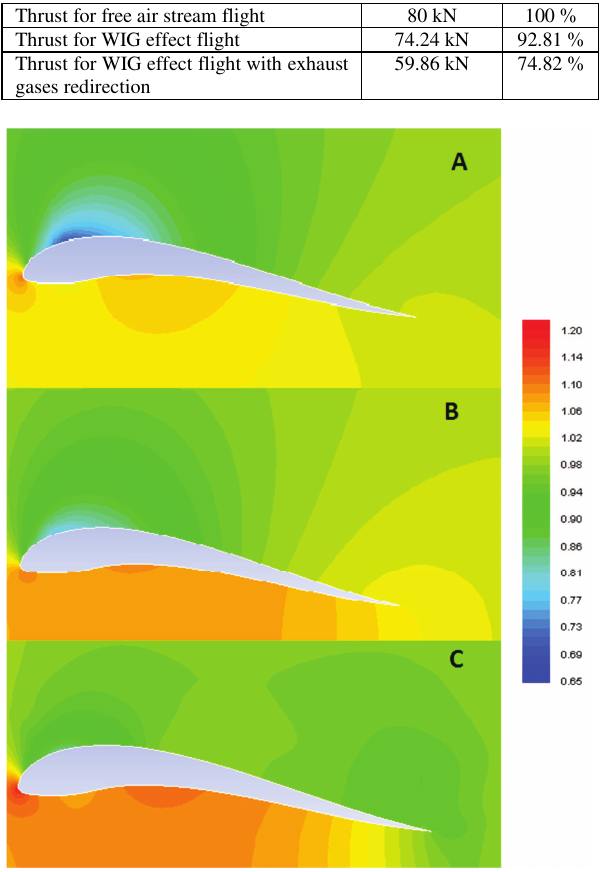
Table 5. Thrust needed to propel aircraft